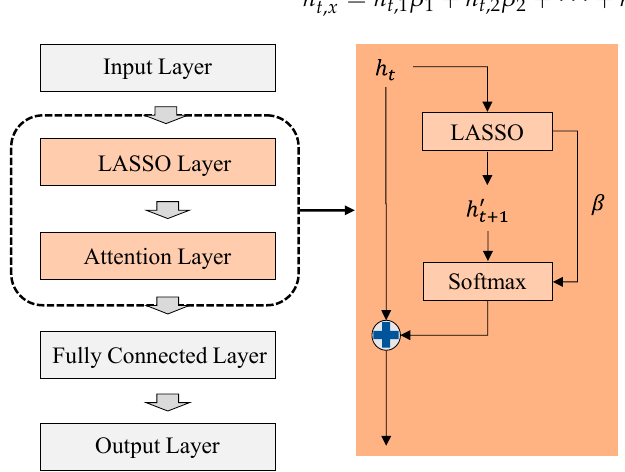
Figure 3. The structure of LAFE.